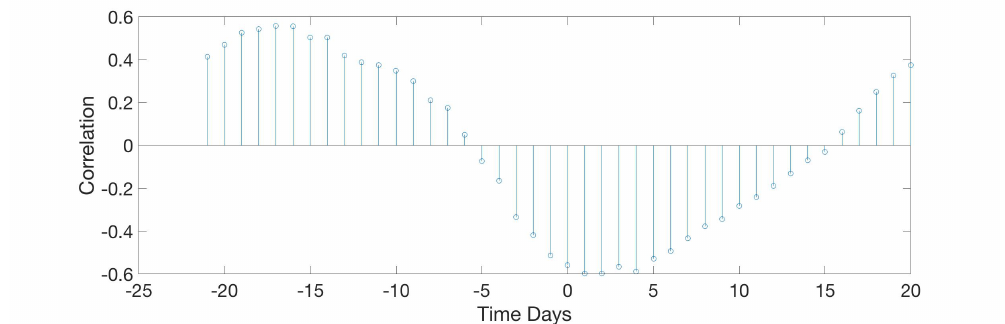
Figure 20. Results of the circular correlation food—max freq. Horizontal axis corresponds to the time (in days), evaluating the delay between the food intake and the maximum frequency detected.